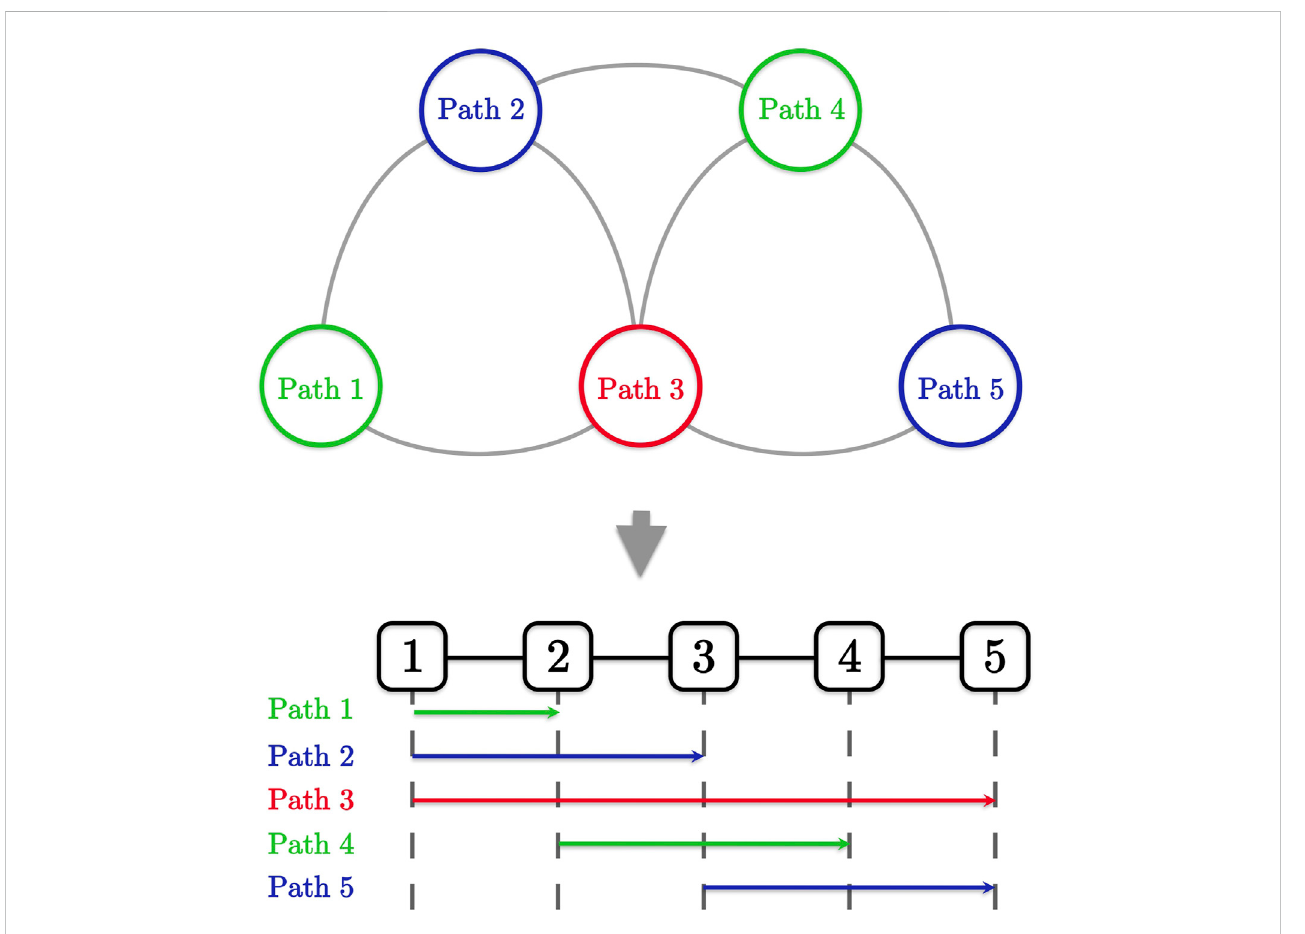
FIGURE 2 Example of a graph coloring problem and its representation to the network graph with